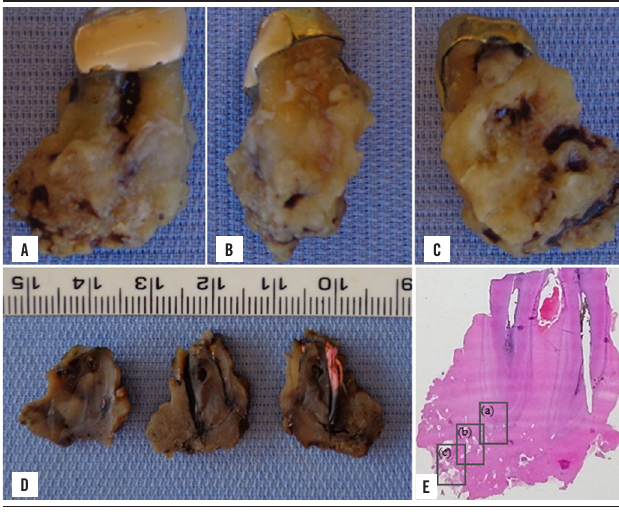
FIGURA 2 – Primeiro molar inferior direito permanente; A, B e C: visão macroscópica do dente extraído com tecido duro lesionado aderido à